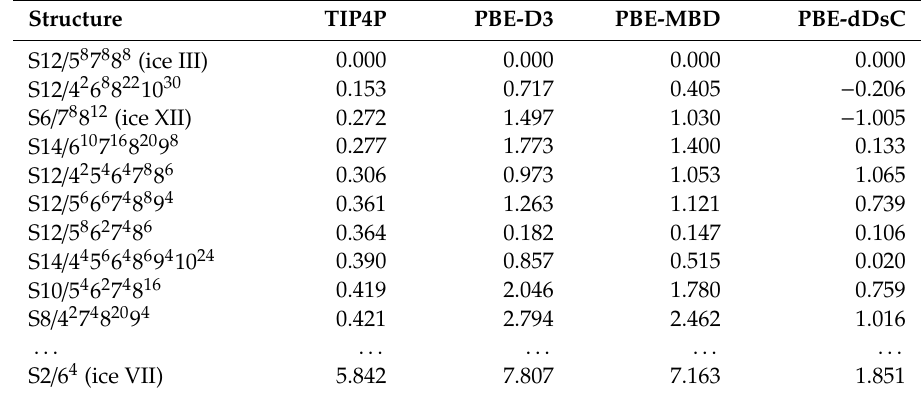
Table 3. Comparison between TIP4P- and DFT-Predicted Ten Lowest-Relative-Enthalpy-per-Molecule Structures at 8 kbar; also shown is that for ice VII, given the 8 kbar